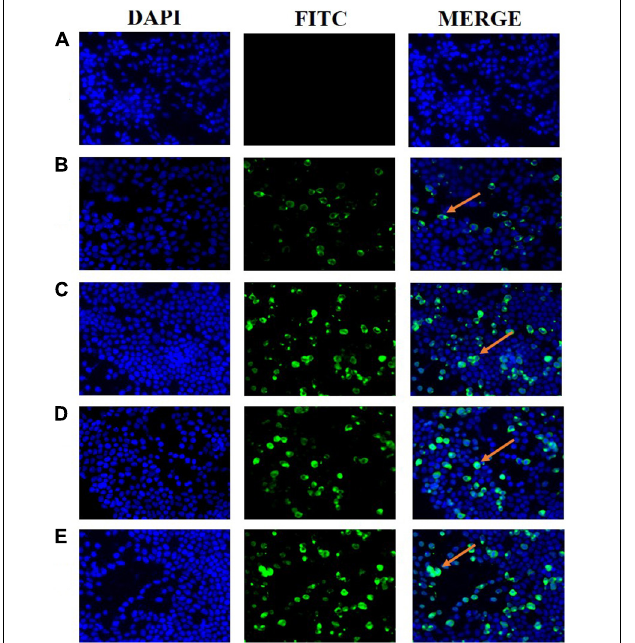
FIGURE 2 | Expression of recombinant plasmids pValac-Ts-ADpsp and pValac-Ts-ADpsp-IL4 in vitro by immunofluorescence analysis. Non-transfected cells acted as the negative control (A) and pValac with GFP-expressing transfected cells served as the positive control (B) . Ts-ADpsp expression in HEK-293T cells transfected with pValac-Ts-ADpsp was observed by IFA using anti-Flag tag monoclonal antibody, FITC-conjugated goat anti-mouse IgG and DAPI (C) . Ts-ADpsp-IL-4 expression in HEK-293T cells transfected with pValac-Ts-ADpsp-IL-4 was observed by IFA using anti-Flag tag monoclonal antibody, FITC-conjugated goat anti-mouse IgG and DAPI (D) . Ts-ADpsp-IL-4 expression in HEK-293T cells transfected with pValac-Ts-ADpsp-IL-4 was observed by IFA using anti-His tag monoclonal antibody, FITC-conjugated goat anti-mouse IgG and DAPI (E) . Arrows indicate the expression of the target protein in HEK-293T cells.